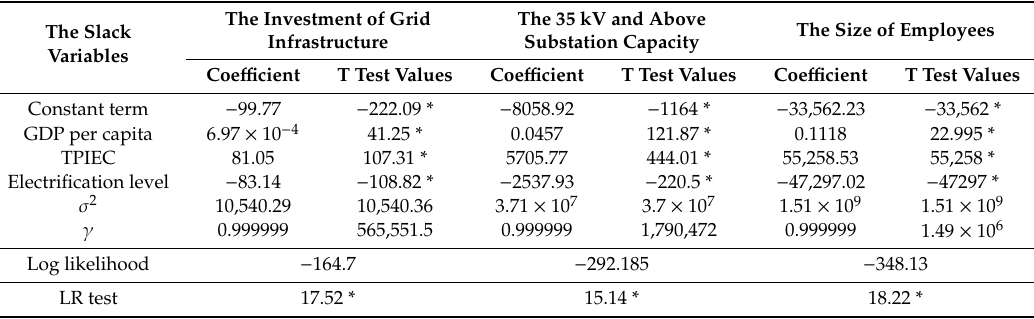
Table 2. The SFA estimation